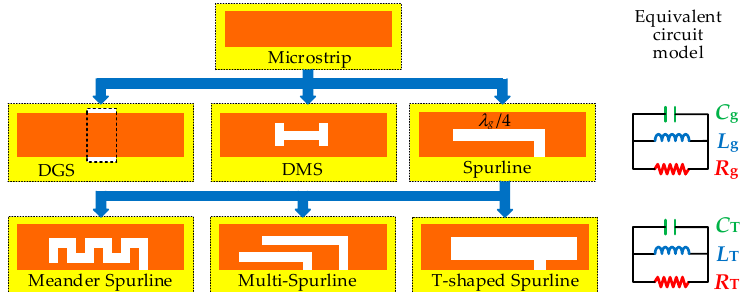
Figure 4. Derivation from the conventional microstrip to the defected ground structure (DGS), defected microstrip structure (DMS), and various spurlines.